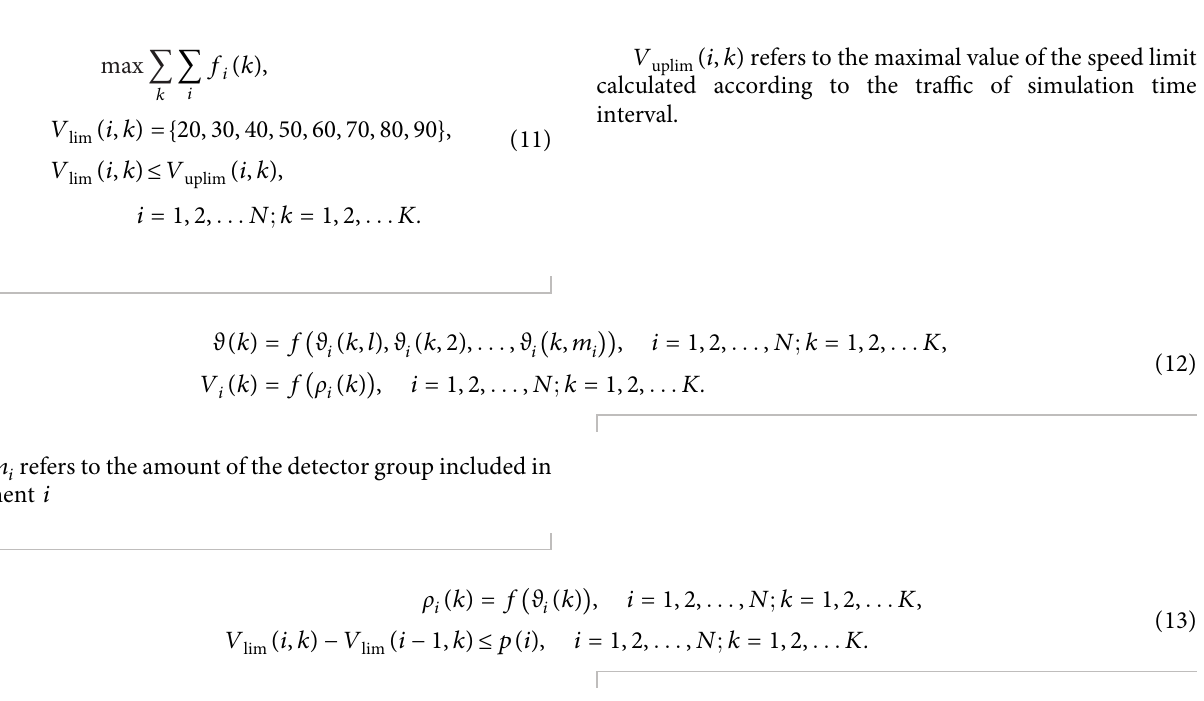
Figure 4: Speed-density curve in